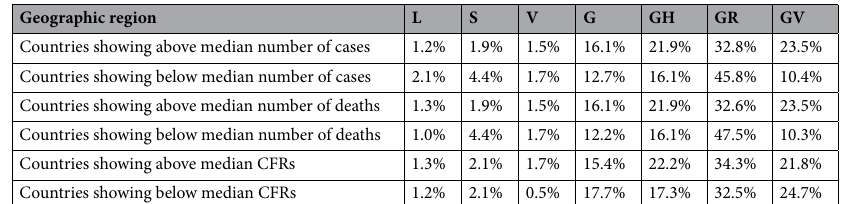
Table 1. Geographical distribution of SARS-CoV-2 clades with respect to disease epidemiology parameters. Chi-square test showed that the distribution bias of all clades among the groups of countries showing above median and below median values for all disease epidemiology parameters was statistically significant (P-value < 0.05).